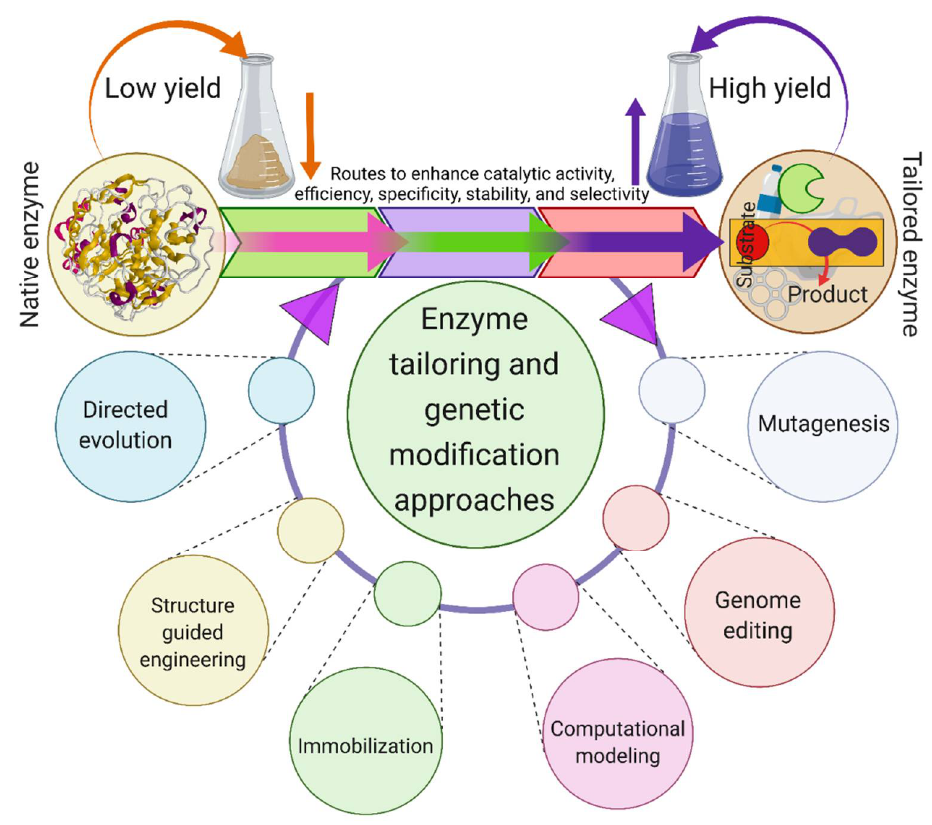
Figure 4. Protein engineering approaches to develop robust catalysts of interest with high catalytic activity, efficiency, specificity, stability, and selectivity, that could enhance PET biodegradation. Created with BioRender.com and extracted under premium membership.